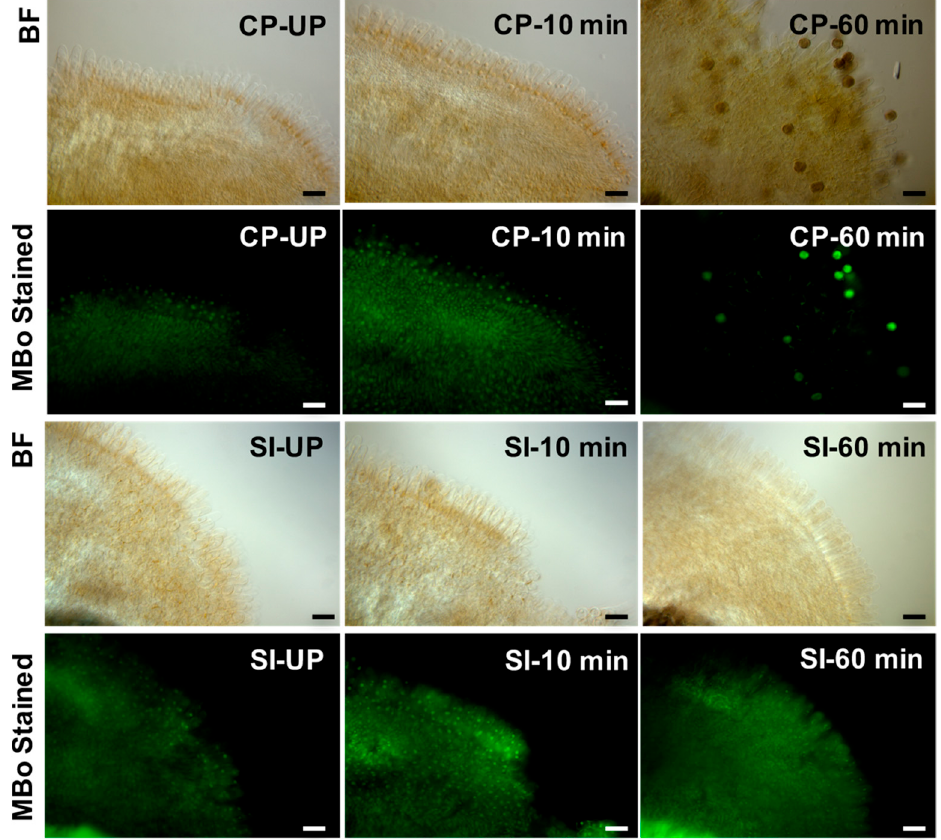
Figure 2. Visualization of MBo-stained papillary cells after 0, 10, and 60 min of pollination, suggesting an increase in MG levels after 10 min in both Westar (compatibly pollinated) and W1 (self-incompatible pollination), which decreases after 60 min of compatible pollination, but persists following self-incompatible pollination. (BF: bright field; CP: compatible pollination; SI: self-incompatible pollination; UP: unpollinated), scale bars = 50 μ m.